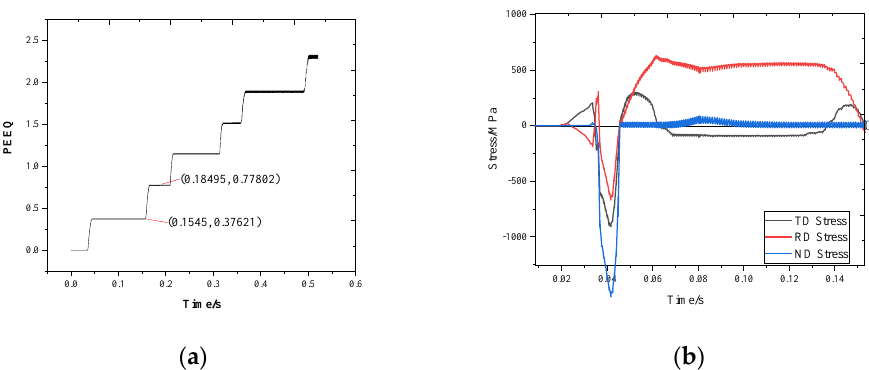
Figure 6. Partial stress at the center of a 0.25 mm pit. Center-point ( a ) stress of first-pass rolling and ( b ) strain of each rolling pass.